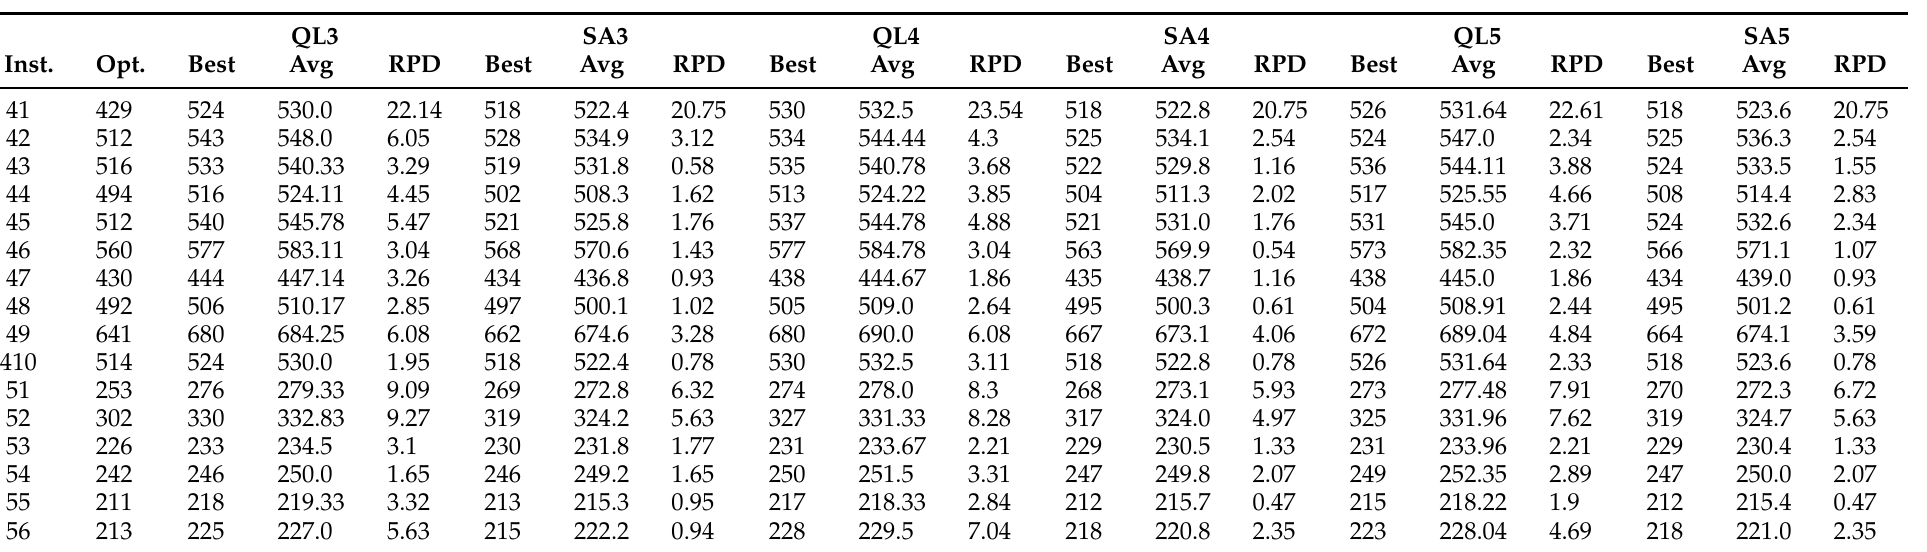
Table 8. Result comparison with WOA employing the approaches QL3, SA3, QL4, SA4, QL5, and